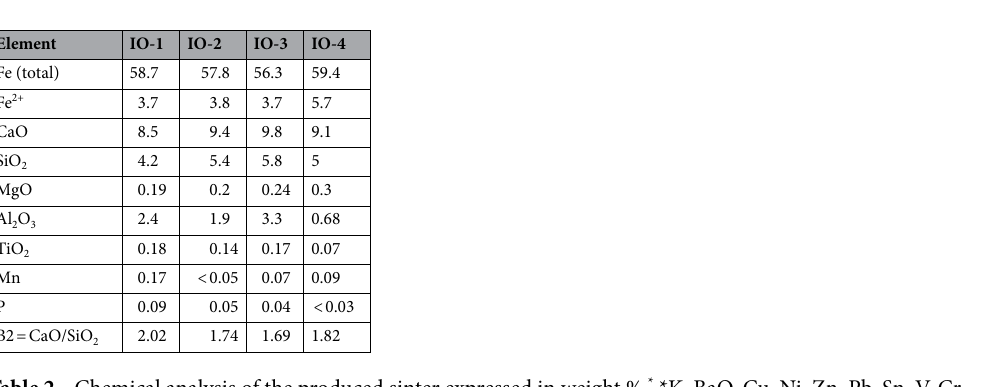
Table 2. Chemical analysis of the produced sinter expressed in weight %. * *K, BaO, Cu, Ni, Zn, Pb, Sn, V, Cr, S, Na, Cl were all measured below detection